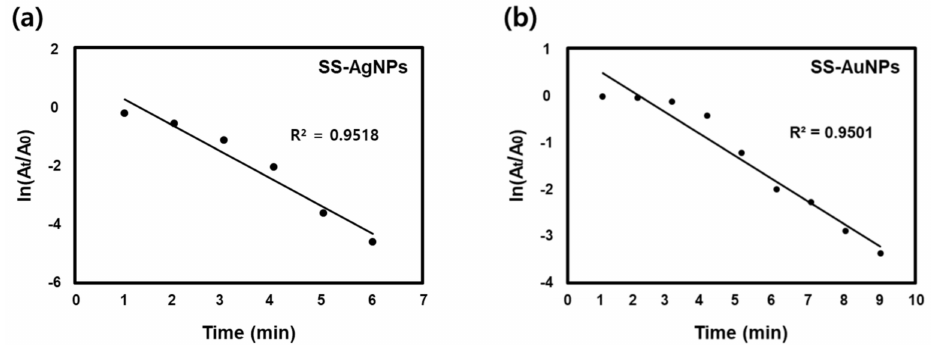
versus time during RB reduction by catalysts, ( a ) SS-AgNPs and ( b ) Figure 10. Plot of ln A t A 0